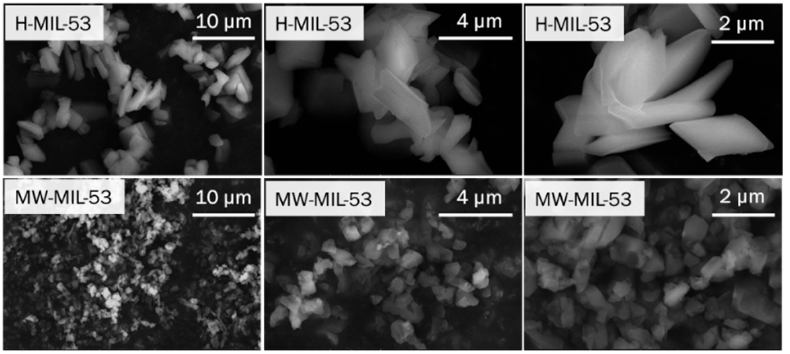
Figure 3. (From left to right) low, medium and high magnification SEM images of (top) H-MIL-53 and (bottom) MW-MIL-53.